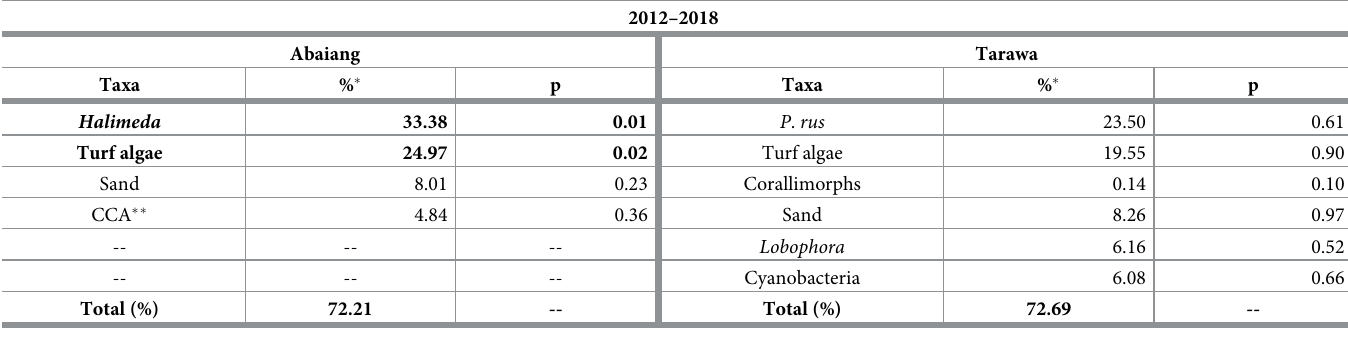
Table 5. Most influential taxa in benthic community difference between 2012–2018, as identified by SIMPER analysis. Statistically significant results are in